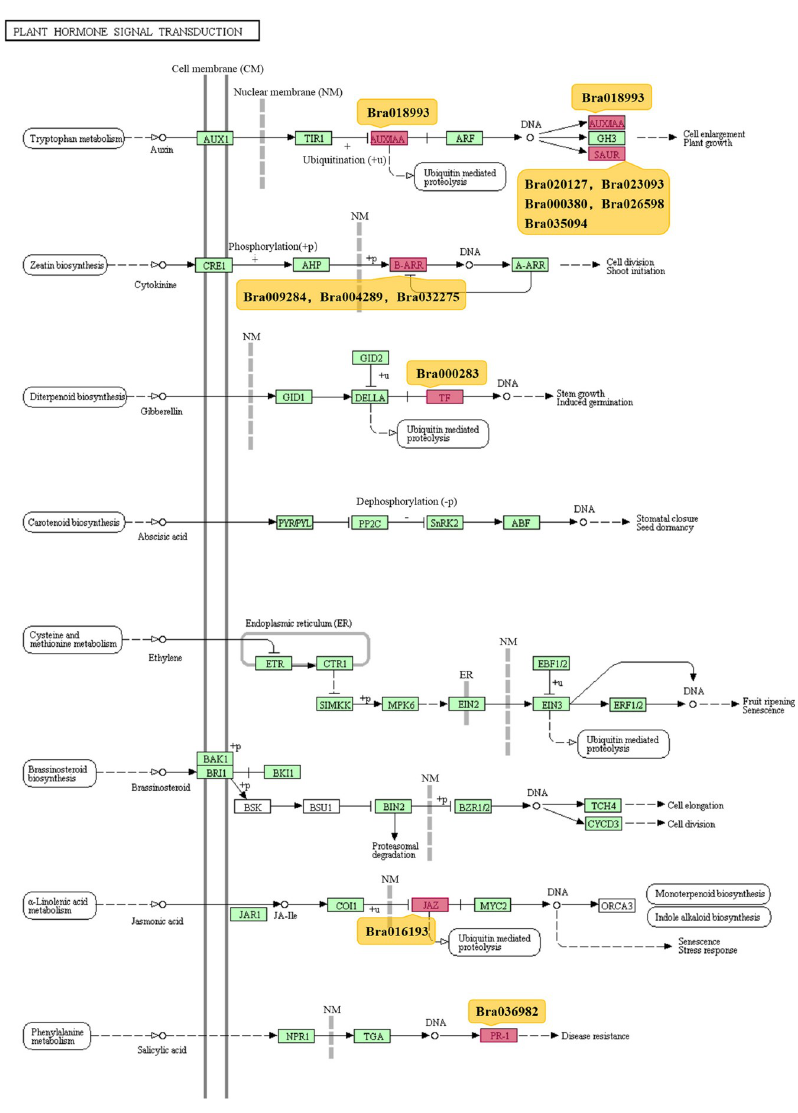
Fig 2. The display of enriched KEGG pathway of plant hormone transduction in positively selected